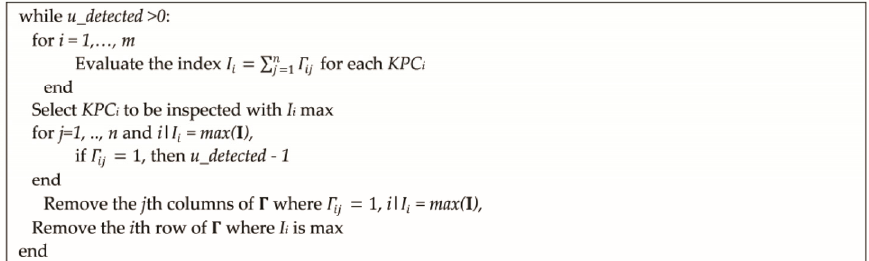
Figure 5. Algorithm to define the minimum KPCs to be inspected for indirectly monitoring all sources of variation.